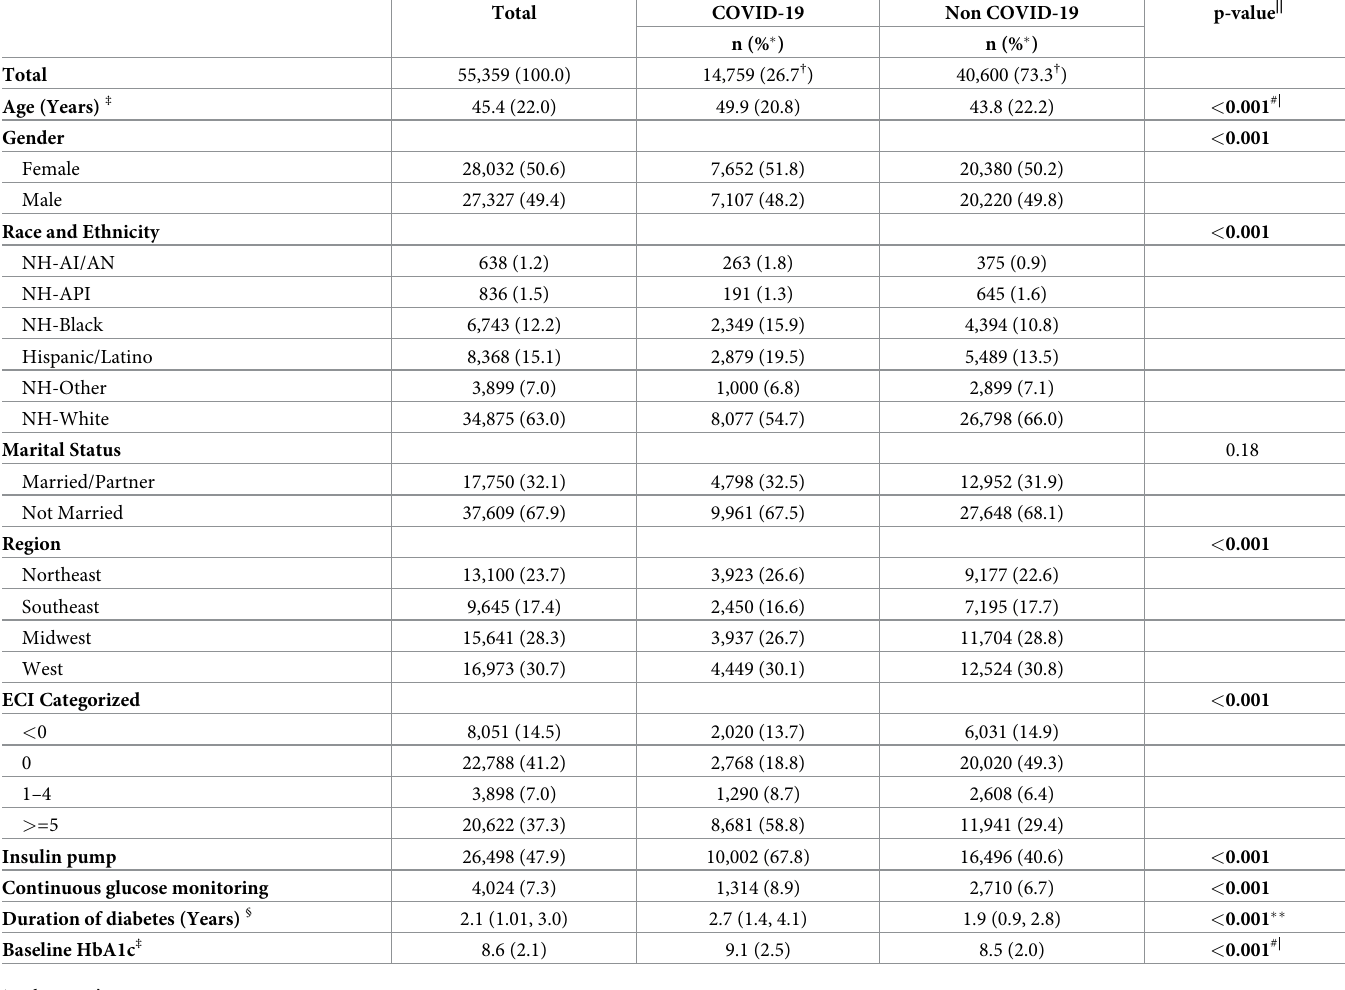
Table 3. Demographic and clinical characteristics of patients previously diagnosed with T1D (overall and stratified by COVID-19